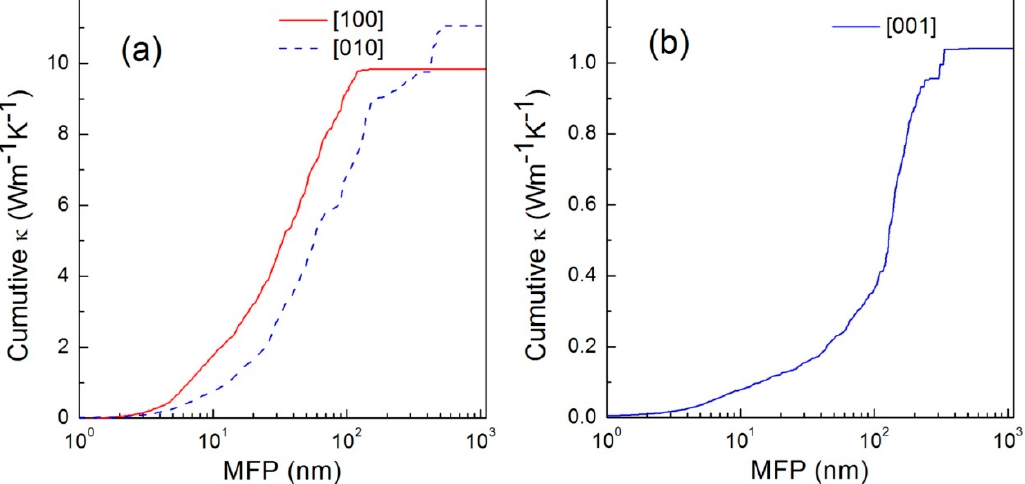
Figure 8. Cumulative thermal conductivity—phonon mean-free path (MFP) graph in WTe 2 in the x, y ( a ) and z ( b ) directions, respectively [51].